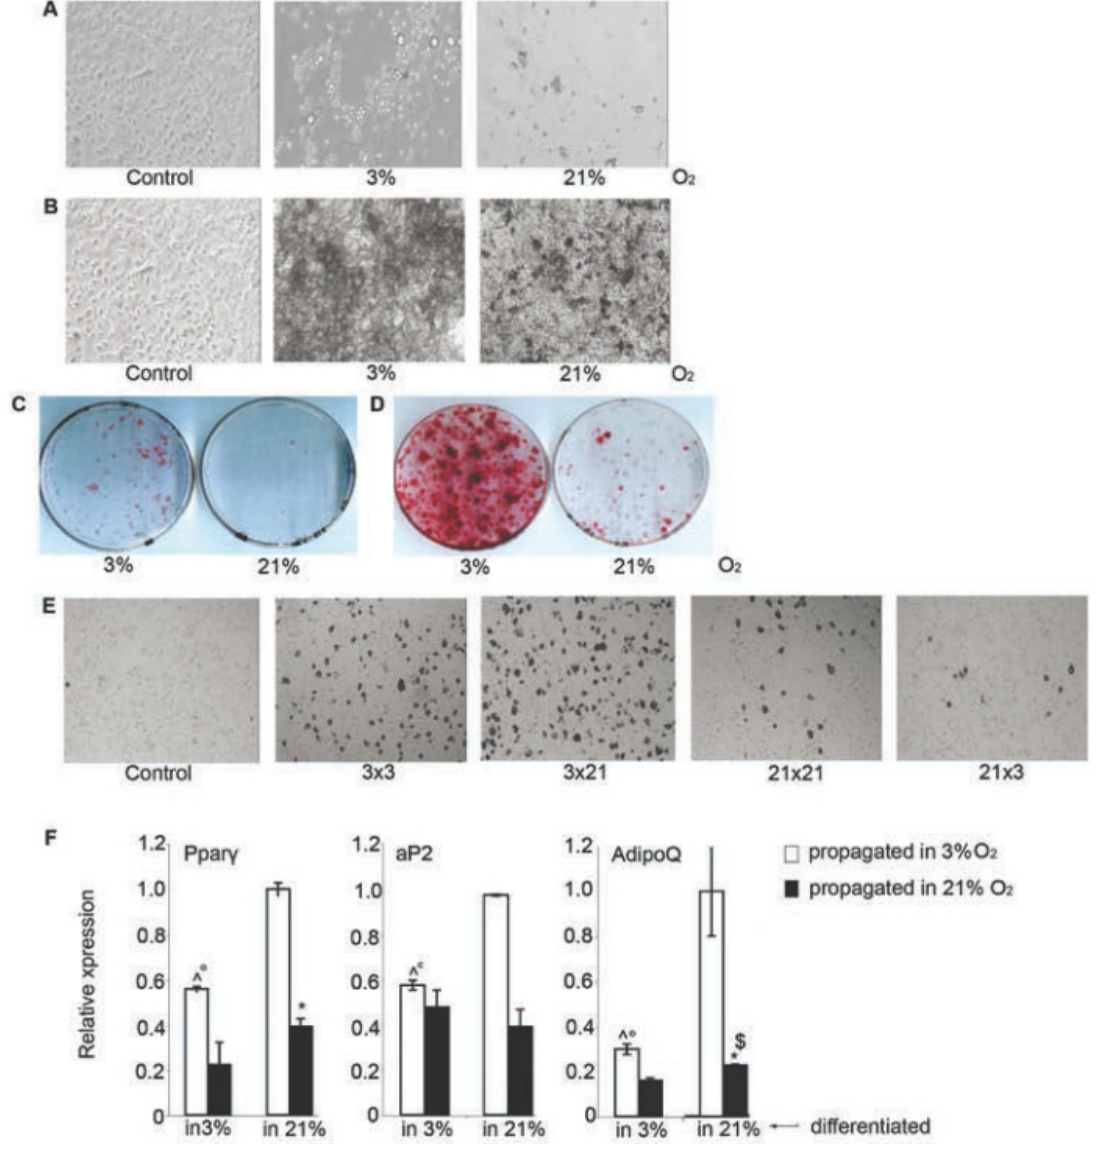
Figure 4. Effect of 3% O on BMSC differentiation. Pictures of BMSC differentiated into 2 adipocytes ( A ) or osteocytes ( B ); Differentiation of BMSC into adipocytes ( C ) and osteocytes ( D ) in CFU-A; ( E ) BMSC were both propagated and differentiated in 3% O 2 (3 × 3) or 21% O (21 × 21); or propagated in 3% O and differentiated in 21% O (3 × 21) 2 2 2 or vice versa (21 × 3) . Representative picture of cells not stimulated with differentiation media is shown as control; ( F ) Relative expression of Ppar γ , aP2, adipoQ in cultures differentiated as in E as estimated by qPCR. Expression of these genes was insignificant in cultures untreated with differentiation media. The difference is statistically significant at p < 0.05 for cells: ° differentiated in 3% O upon propagation in 3% or 21% O , 2 2 * differentiated in 21% O upon propagation in 3% or 21% O , ^ differentiated in 3% or 2 2 upon propagation in 3% O , $ differentiated in 3% or 21% O upon propagation 21% O 2 2 2 in 21% O 2